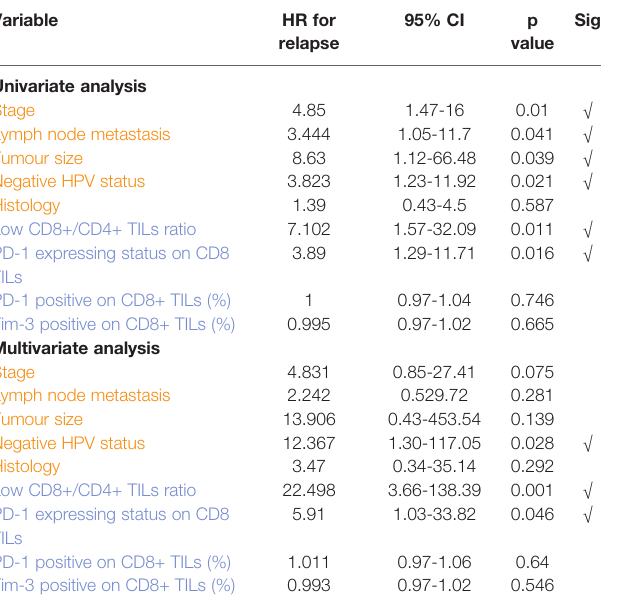
TABLE 2 | Univariate and multivariate cox proportional hazard models for relapse. TABLE 3 | Univariate and multivariate cox proportional hazard models for